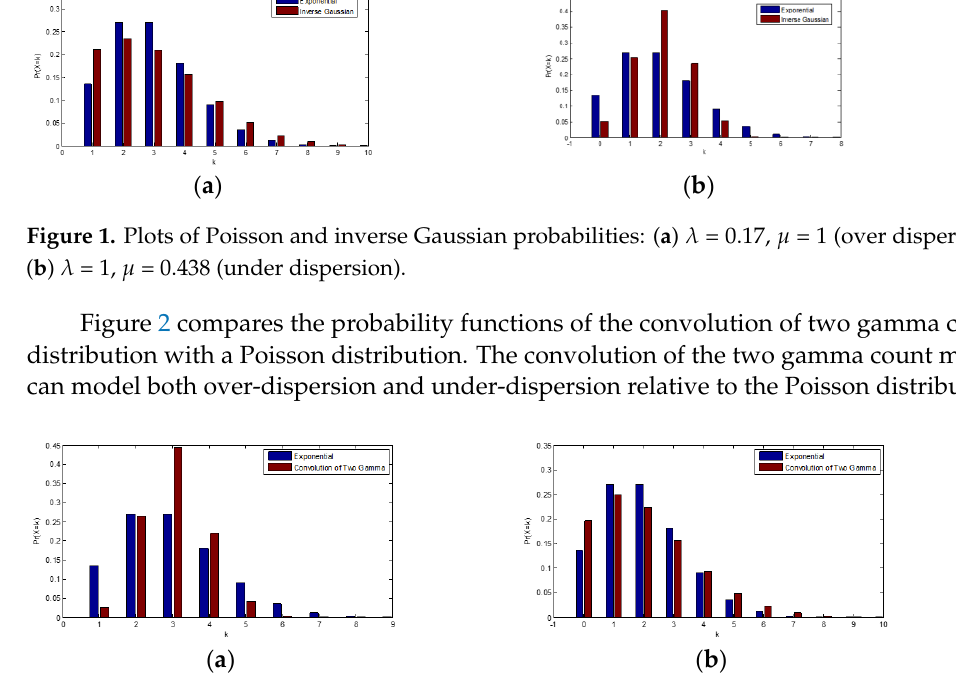
Figure 2. Plots of Poisson and convolution of two gamma probabilities: ( a ) α 1 = 1.5, α 2 = 1.9 (under dispersion); ( b ) α 1 = 0.2, α 2 = 0.5 (over dispersion).